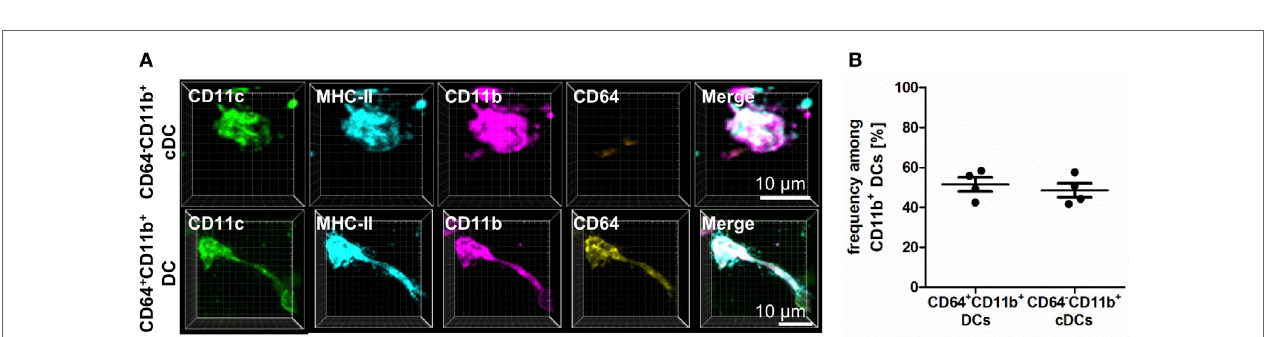
FigUre 2 | CD11b + dendritic cells (DCs) differ in CD64 expression based on their ontogenetic origin. Precision cut lung slices (PCLS) (300 µm) from naive C57BL/6 mice were generated and stained with anti-CD11c, anti-MHC-II, anti-CD11b, and anti-CD64 mABs. Stained slices were evaluated with confocal microscopy. (a) Immunohistochemistry (IHC) of CD11b + conventional DCs (cDCs) and CD64 + CD11b + DCs. Single-color and merged color display with CD11c (green), MHC-II (turquois), CD11b (purple), and CD64 (yellow). Data are representative of four independent experiments. (B) Frequency of CD11b + cDCs and monocyte-derived DCs (moDCs) among CD11b + DCs. Lines indicate mean ± SEM. Differences between groups were tested by Mann–Whitney U -test (B) for significance.